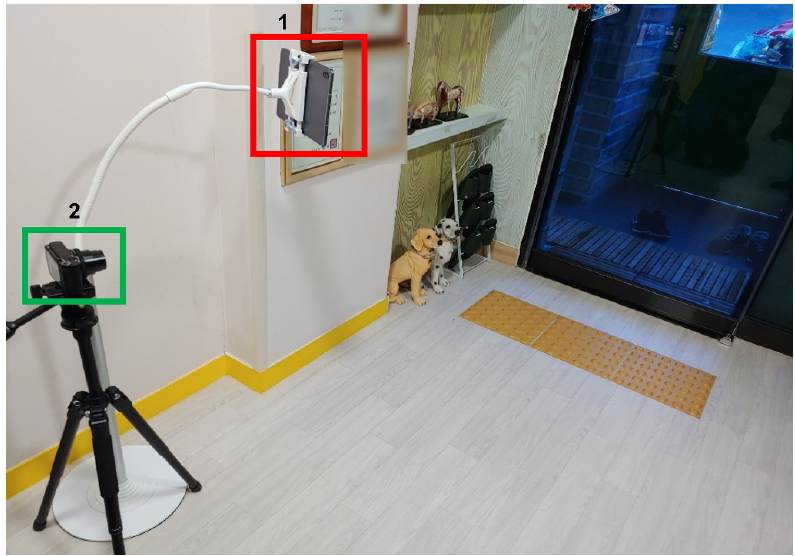
Figure 14. Installation of the camera indoors